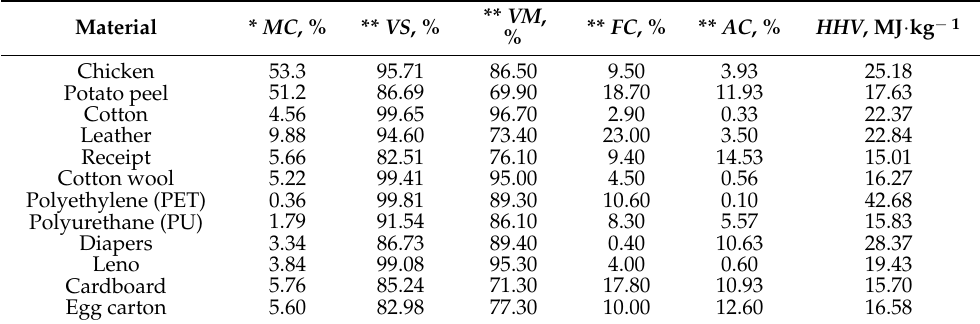
Table 1. Proximate analysis results of research materials.